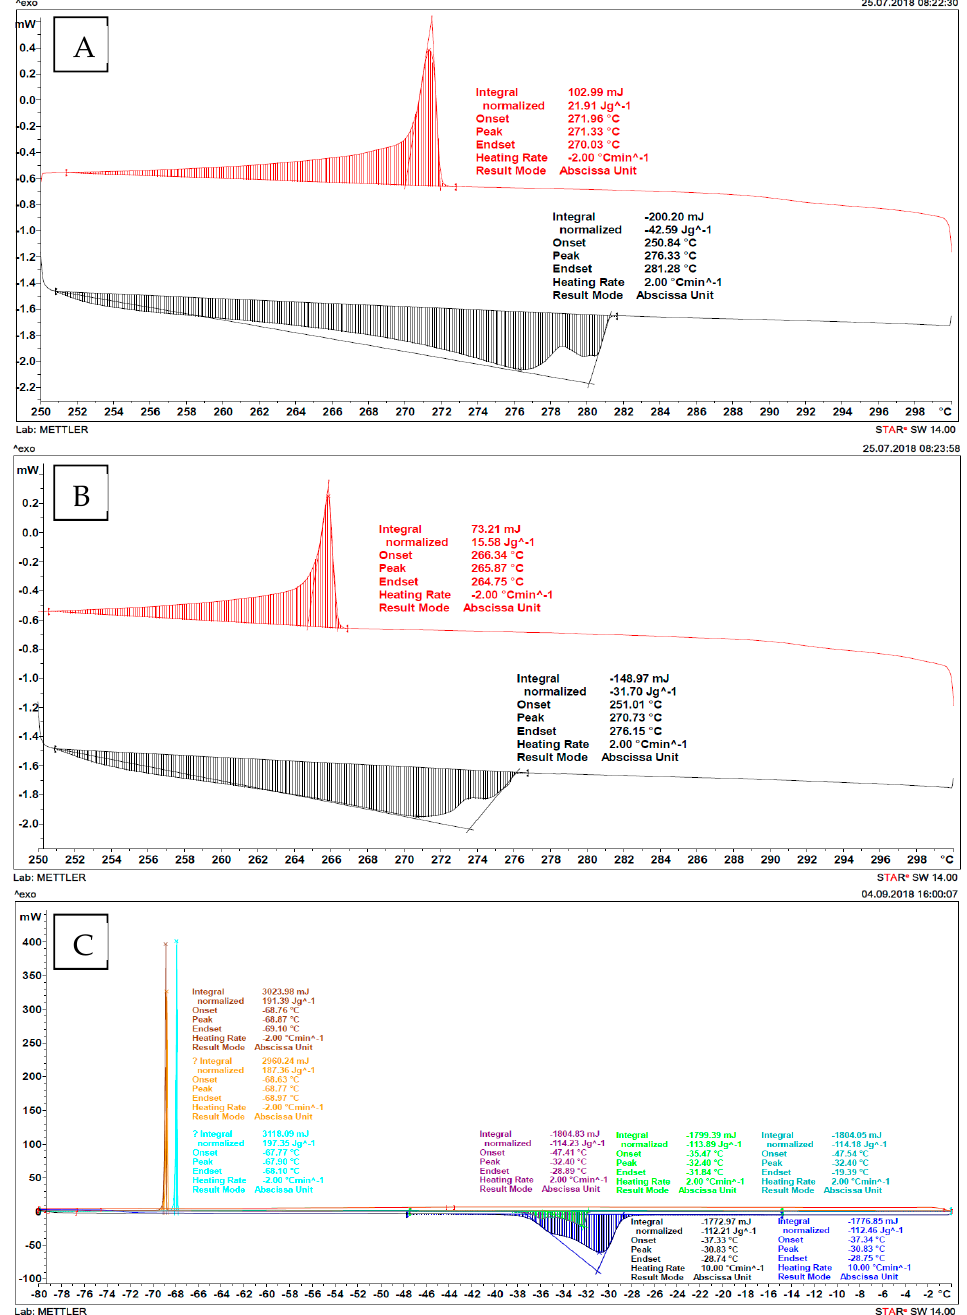
Figure 2. ( A , B ) DSC graphs of the 5th and 6th heating-cooling cycles of oxa-adamantanone at 2 ◦ C/min respectively. The enthalpies of each cycle can be seen progressively decreasing to about 15 J/g. The phase change transition of oxa-adamantanone occurs over a broad temperature range of 30 ◦ C. ( C ) DSC measurement of γ -valerolactone with six consecutive heating-cooling cycles at 10 ◦ C/min and 2 ◦ C/min for comparison with oxa-adamantanone results. Here although no crystallization took place for 10 ◦ C/min heating rates, the enthalpies of fusion were stable for all other cycles and the phase transition was registered over narrow temperature ranges.